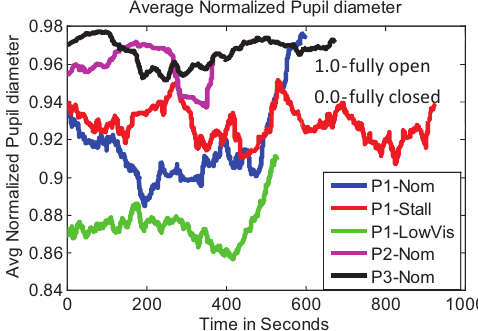
Figure 10. Normalized pupil